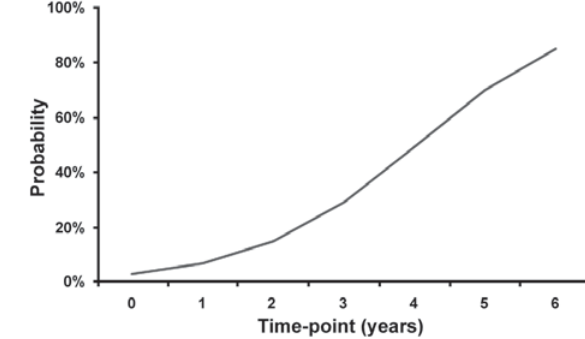
Figure 2- Relationship between non-nutritive sucking duration and the probability of having anterior open bite (derived from the logistic regression model shown